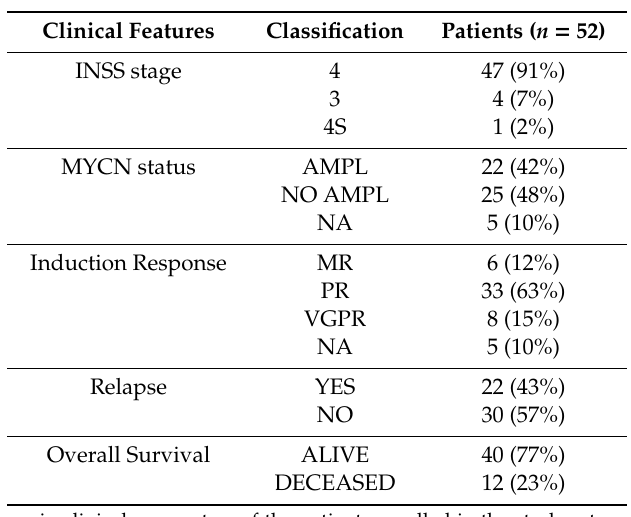
Table 1. Clinical information of the patient